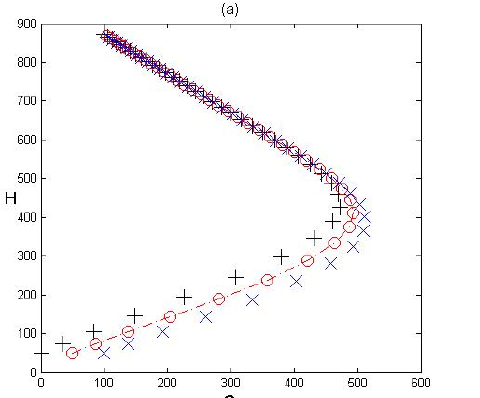
Figure 4. ( a ) The phase diagram for spreaders and hibernators in 𝓡 𝟎 > 𝟏 ; ( b ) The time series for spreaders with different initial value 𝑺(𝟎) under 𝓡 𝟎 > 𝟏 , respectively.